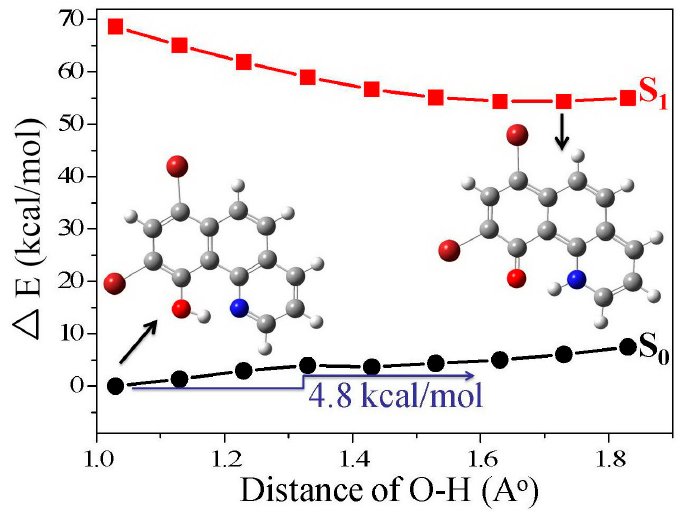
Figure 5. Selected frontier molecular orbitals involved in the excitation and emission of 1 .